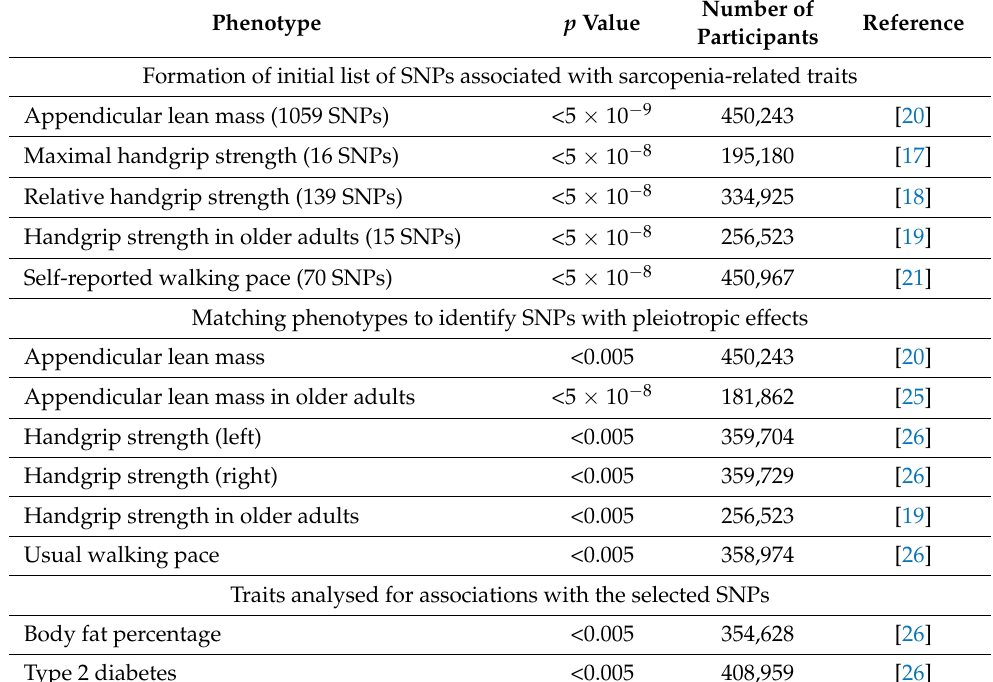
Table 1. The list of phenotypes used from the studies involving UK Biobank